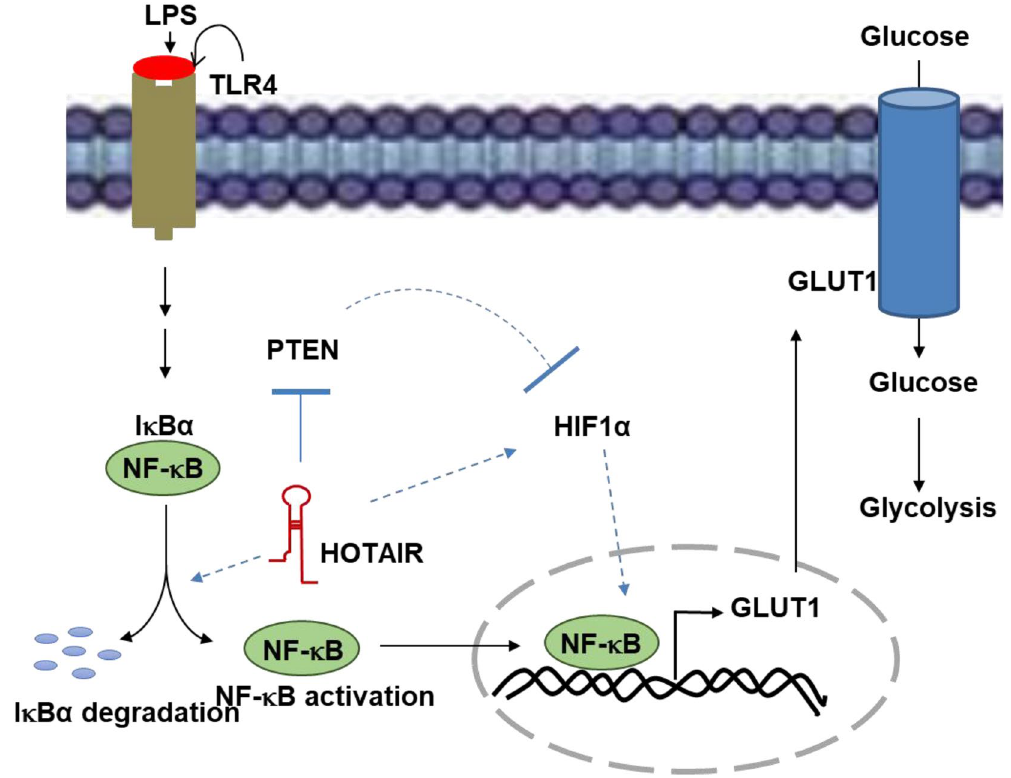
Figure 8. Proposed model for HOTAIR mediated regulation of glucose metabolism during inflammation. When TLR4 senses LPS, NF-κB is activated that induces HOTAIR expression. In turn, HOTAIR facilitates IκBα degradation and enhances NF-κB activation, its nuclear translocation, and binding to NF-κB regulated Glut1 gene promoter inducing its expressions. Overexpressed Glut1 is translocated to membrane, allows increased glucose uptake and glucose metabolism, during inflammation and immune response. PTEN is repressed by HOTAIR under LPS-stimulation. Thereby, HOTAIR relieved PTEN mediated suppression of HIF-1α. Thus HOTAIR mediated repression of PTEN and induction of HIF-1α under LPS-stimulation, contribute increased Glut1 expression and glucose